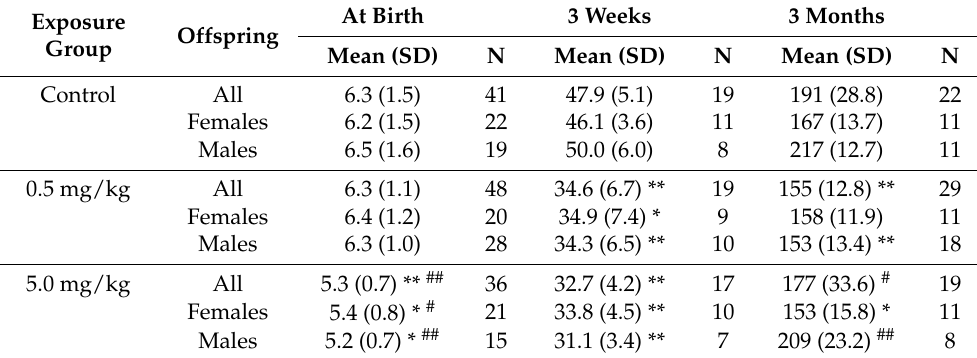
Table 1. Prenatal Aflatoxin B1 Exposure and Offspring Weight